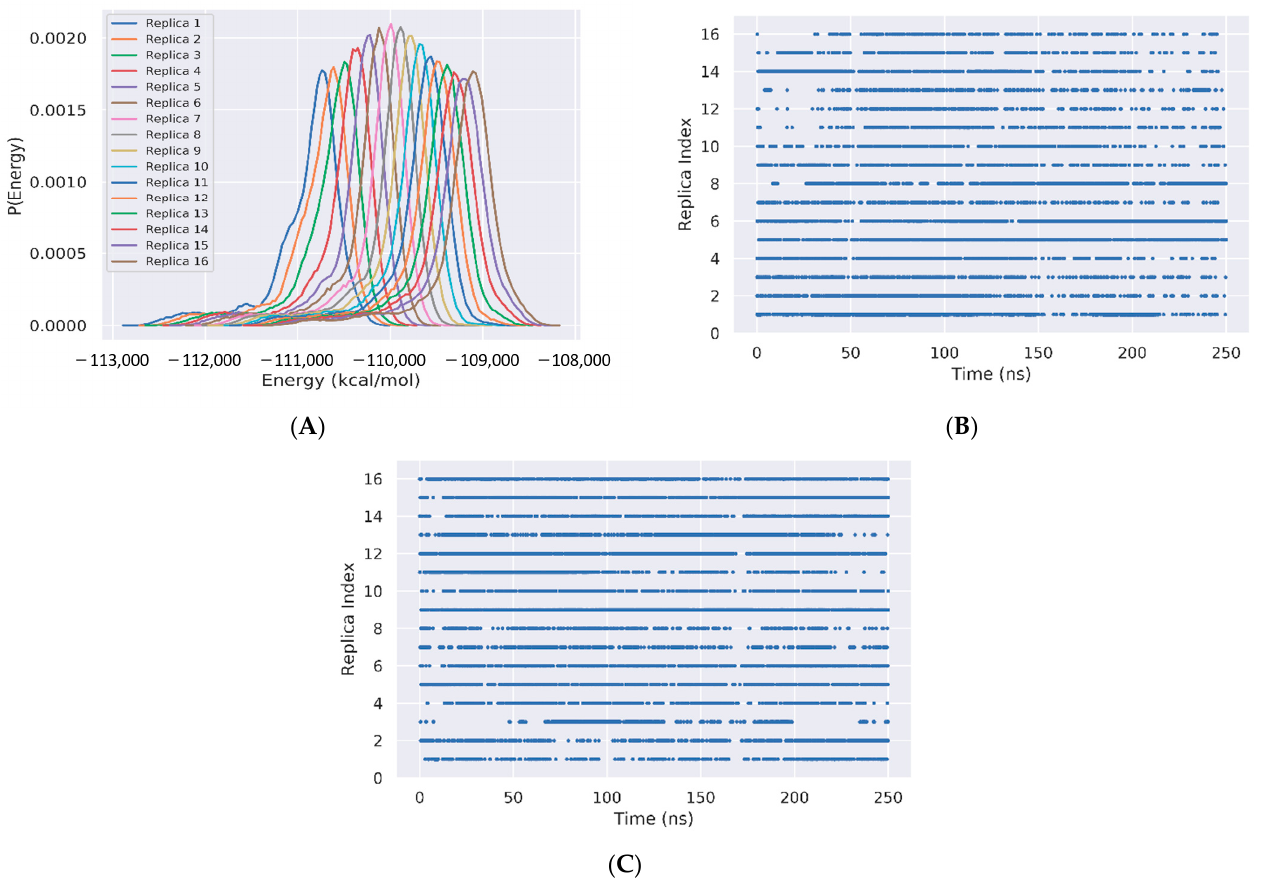
Figure 2. REST2 Sampling. ( A ) Overlap of the total potential energies for replicas 1 to 16. ( B , C ) Ex- changes of coordinates as a function of simulation time of replica 1 and replica 16, respectively.